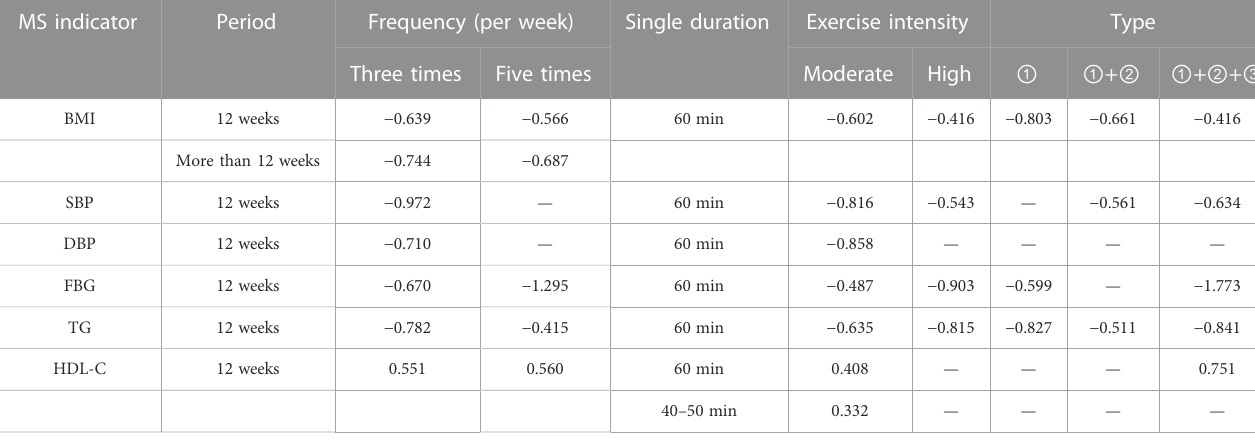
TABLE 10 Intervention effects of different intervention